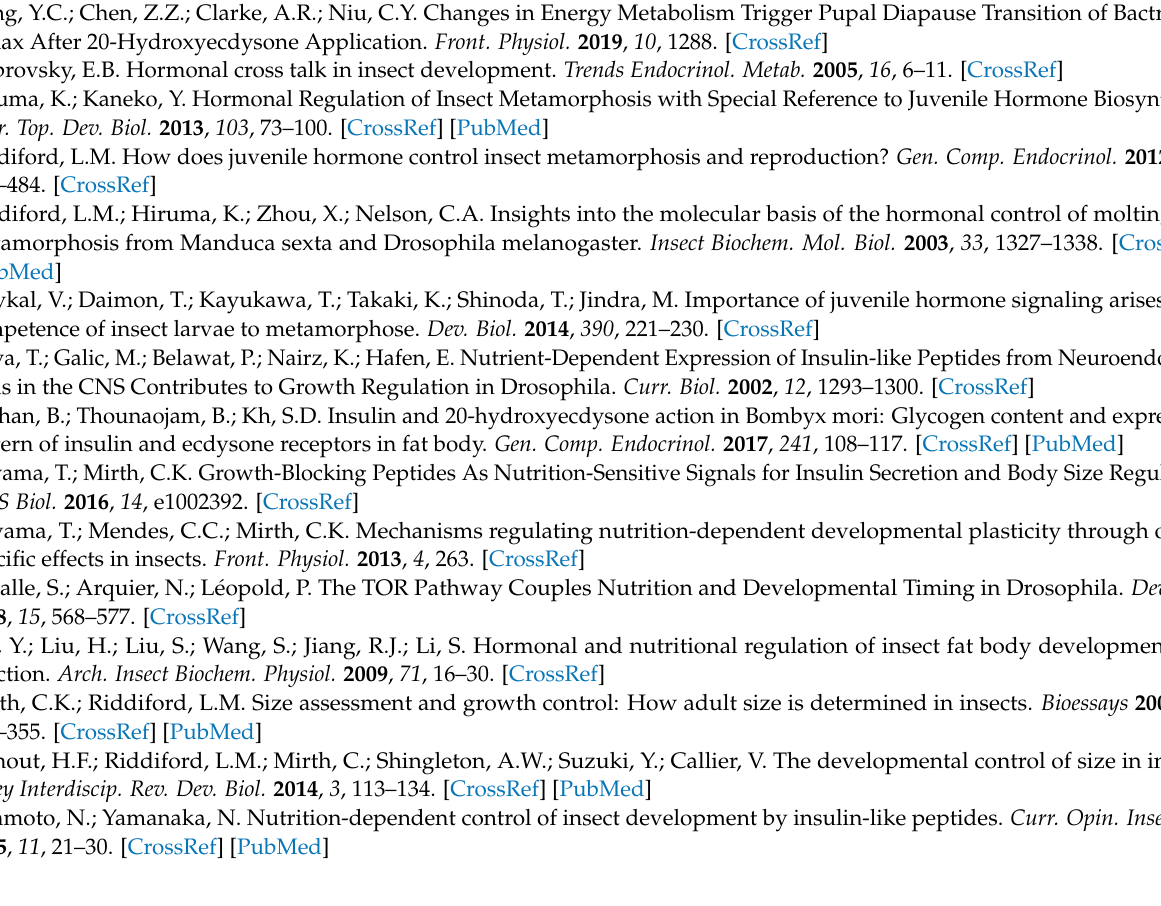
metabolism pathway; Table S1. The primer sequences used for qPCR analysis and dsRNA primers sequence; Table S2. Sample information for metabolomics; Table S3. List and detailed information of the 896 metabolites identified in honeybee larvae; Table S4. List of differential metabolites between CK-5d and 20E-5d; Table S5. List of differential metabolites between CK-6d and 20E-6d; Table S6. List of differential metabolites between CK-7d and 20E-7d; Table S7. List of common differential metabolites between CK-6d vs 20E-6d and CK-7d vs 20E-7d; Table S8. Pathway analysis results from the honeybee larvae metabolomics for the six pairwise